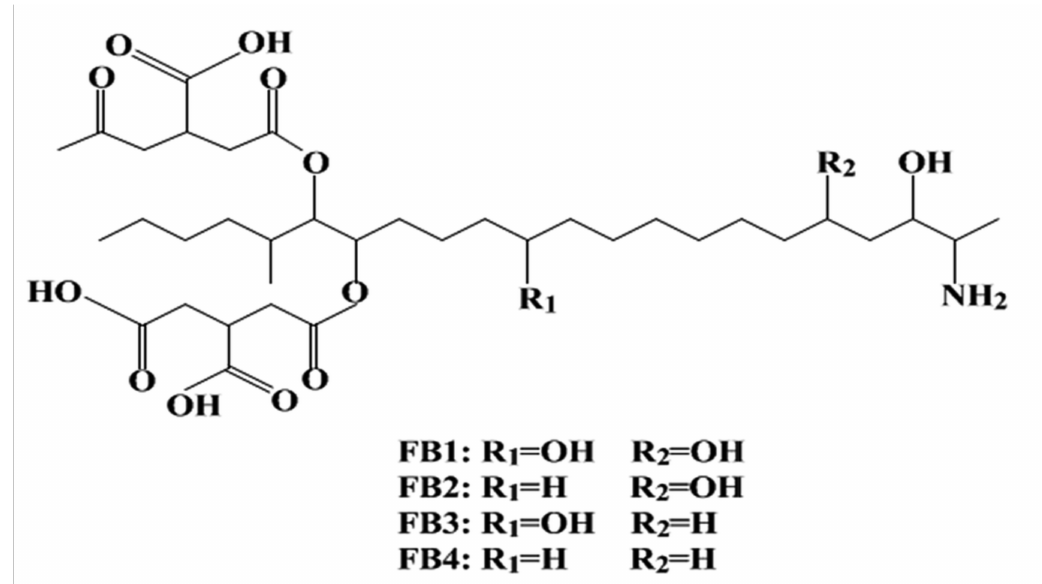
Figure 2. Chemical structure of fumonisin